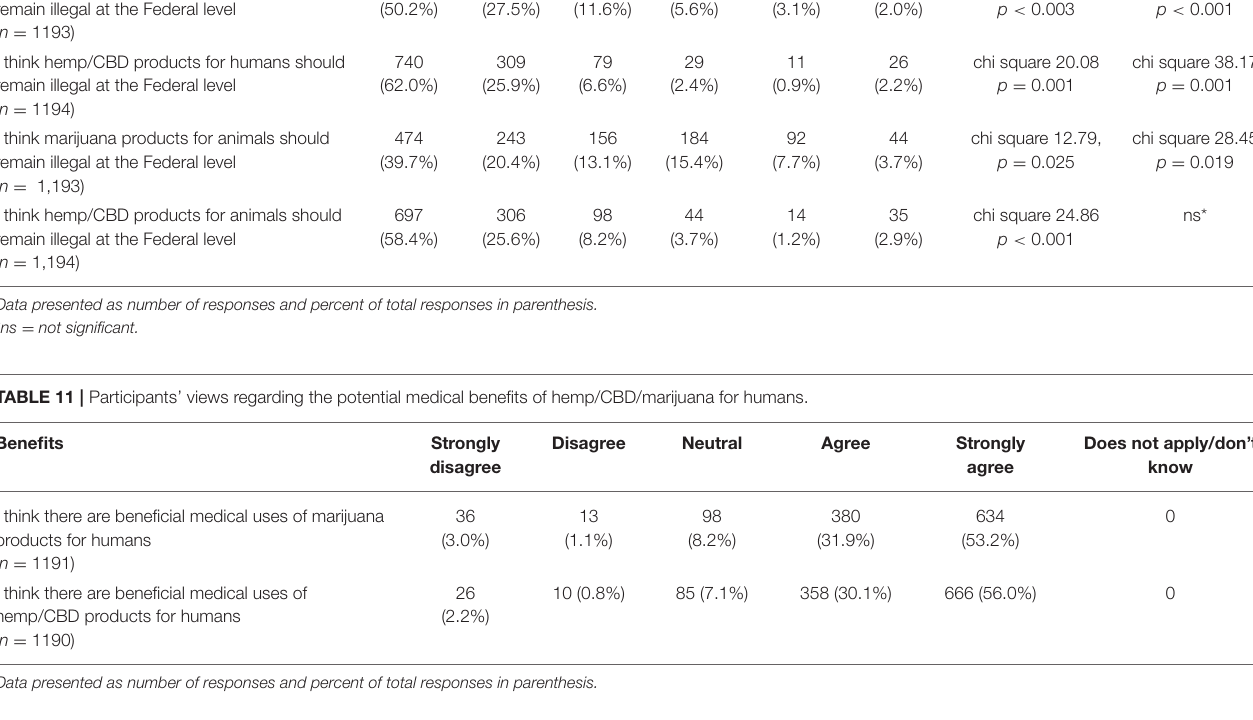
Does not agree apply/don’t know